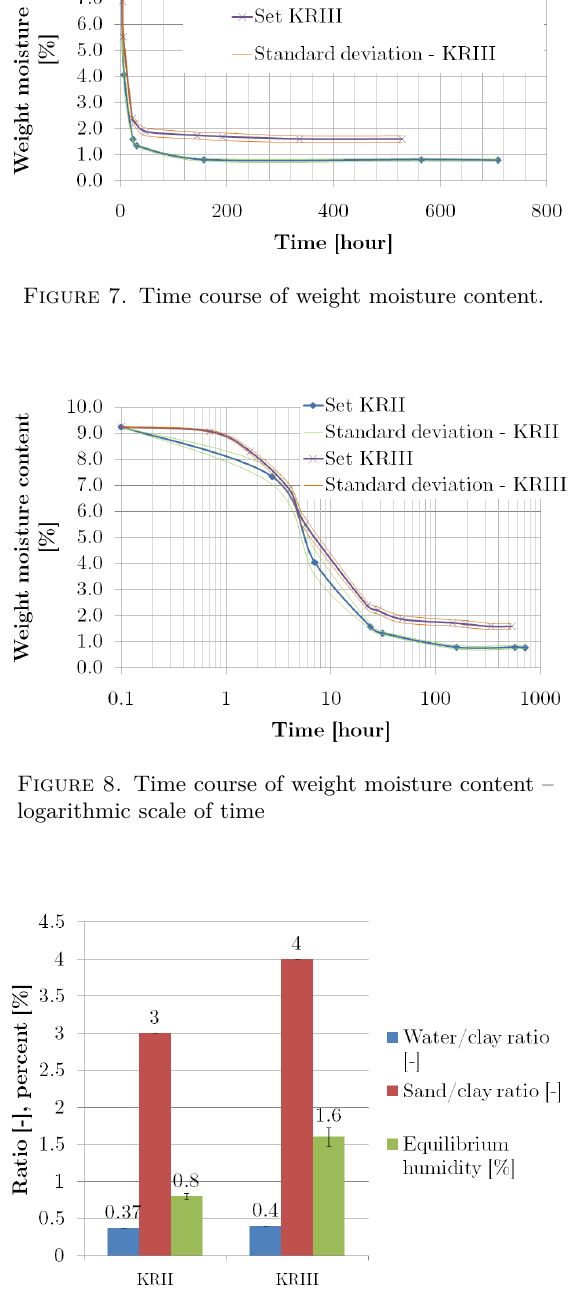
Figure 9. Ratio of the clay and water in mixture and resultant equilibrium